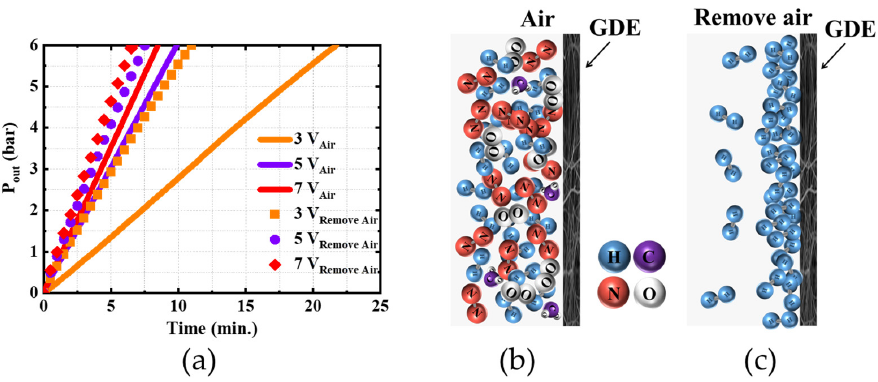
Figure 4. ( a ) Effect of the presence or absence of air in the anode on the cathode pressure at an inlet pressure of 1 bar. ( b ) Anode chamber without air removed. ( c ) Anode chamber with air removed.